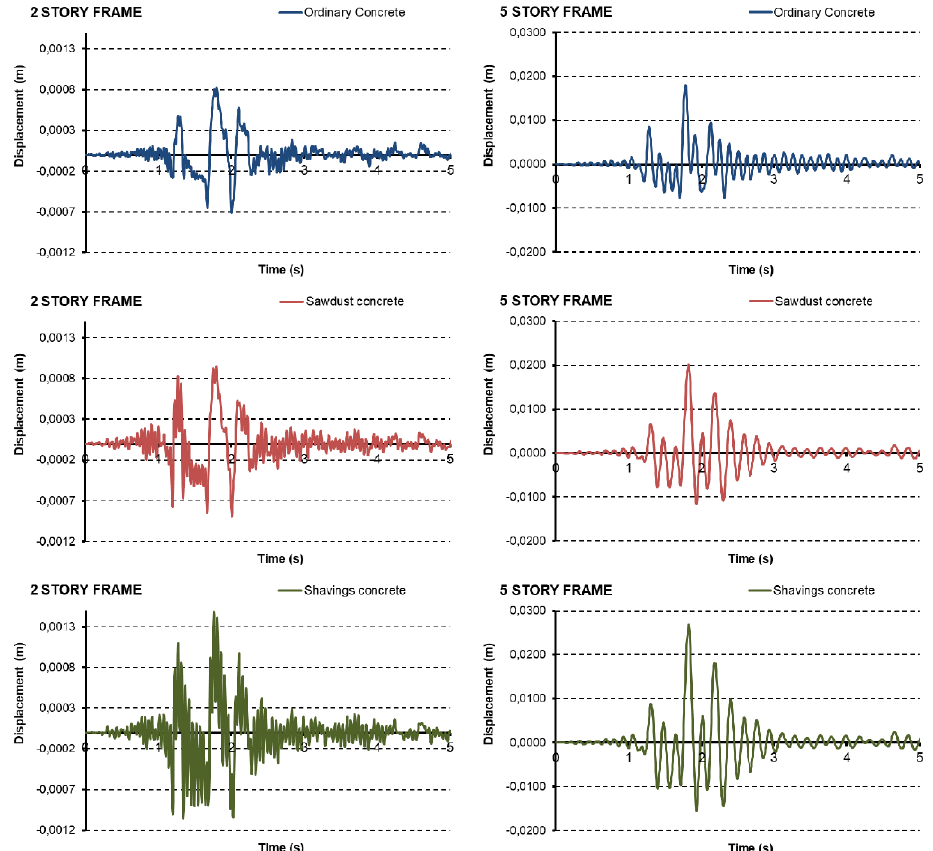
Figure 10. Frames time-history diagrams: ( left ) 2-storey frames; ( right ) 5-storey frames.